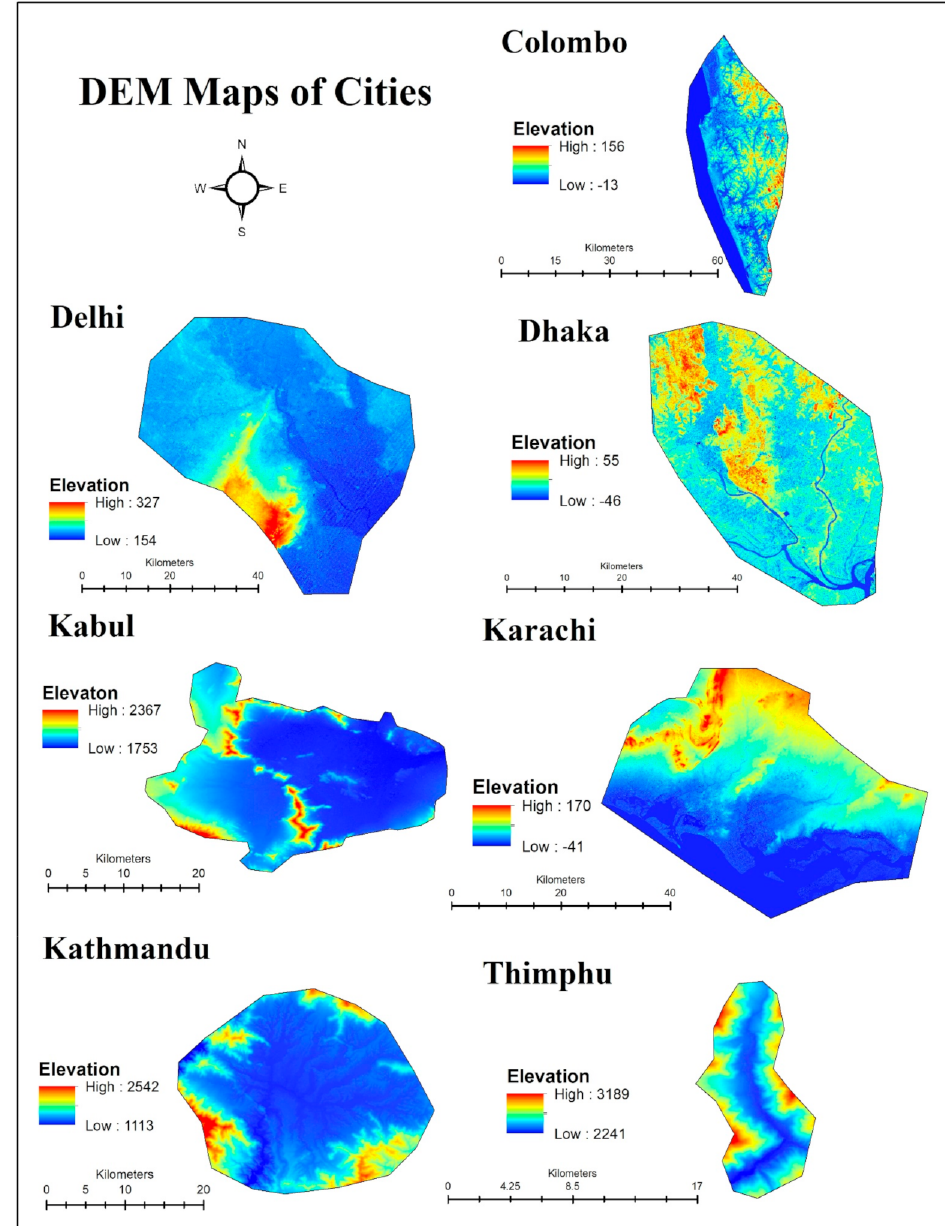
Figure 7. DEM Maps of SA Cities